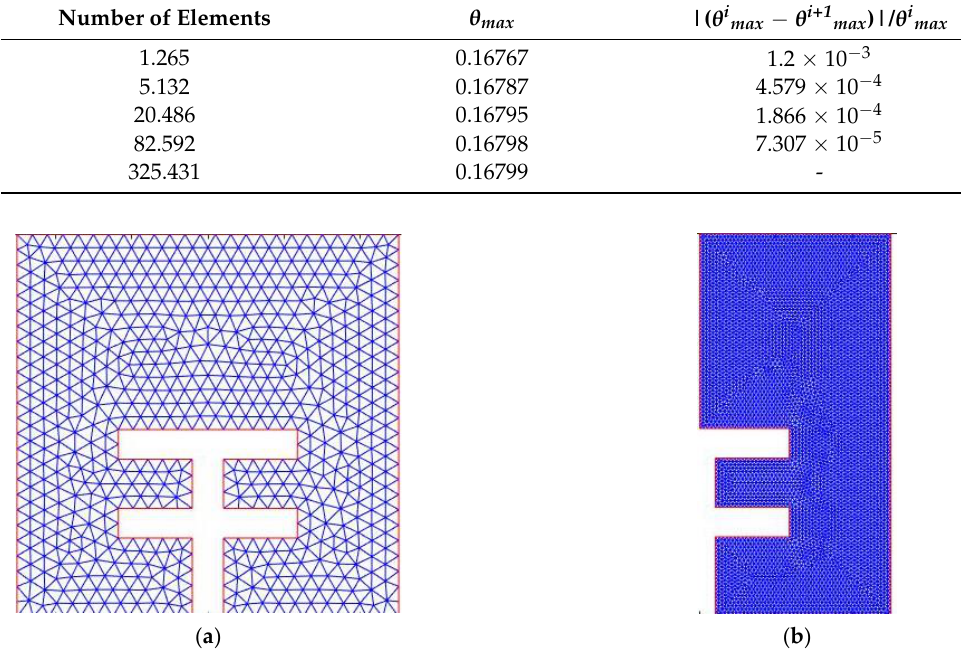
Table 1. Results of grid independence test.